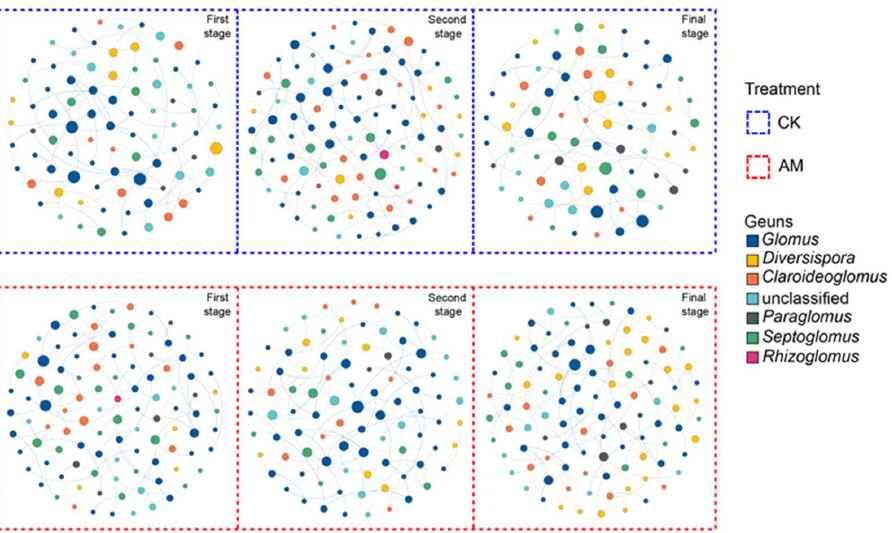
Figure 7. Overview of the networks under different growth stages and inoculation with node sizes being proportional to node degrees.